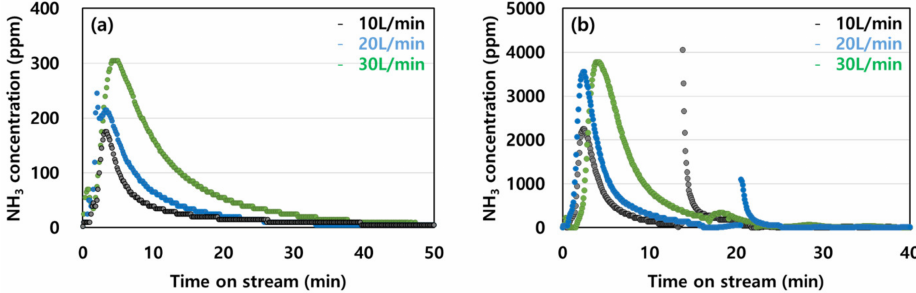
Figure 6. Effects of desorption flow rate on the adsorption of NH 3 at concentrations of ( a ) 40 ppm and ( b ) 1000 ppm at 100 ◦ C on activated